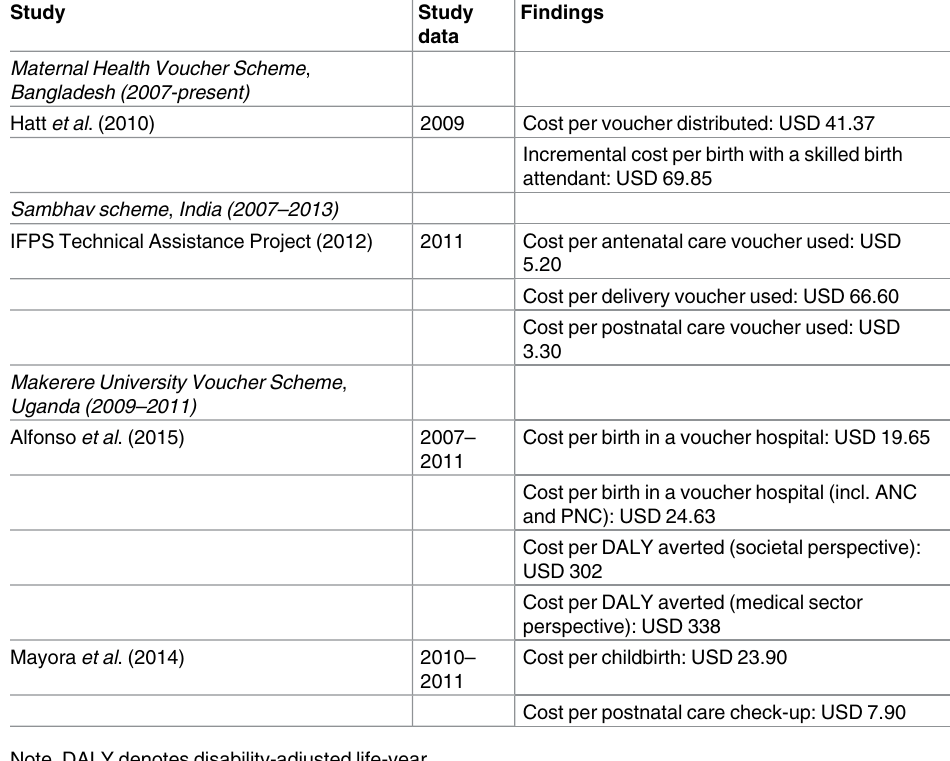
Table 7. Costs, cost-effectiveness and cost-utility of vouchers for maternity care services. Study Study